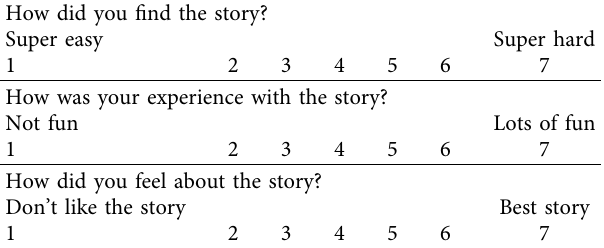
Figure 4: Ages of students. Table 3: Questionnaire to measure users’ responses to eStories.